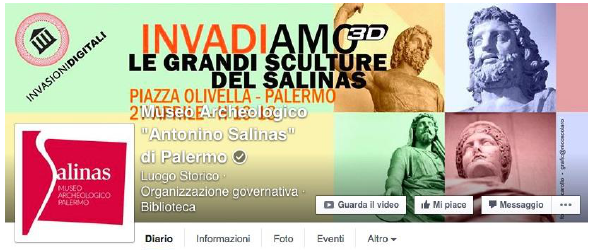
Figure 1. The social event of the 3D # digitalinvasion